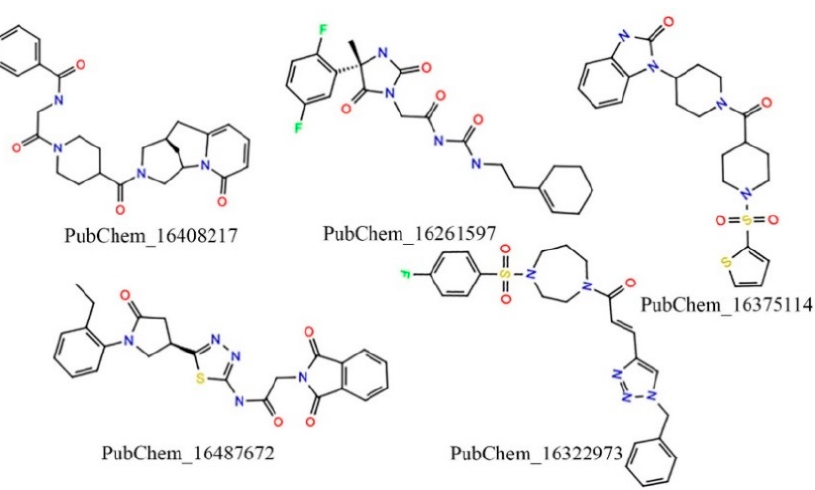
Figure 5. Two-dimensional (2D) representation of the final promising proposed CYP3A5